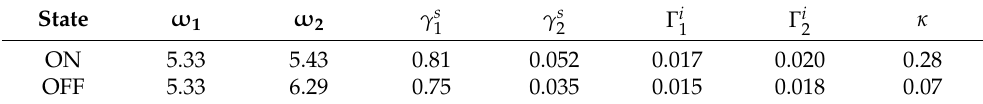
Table 1. Fitting parameters based on CMT.